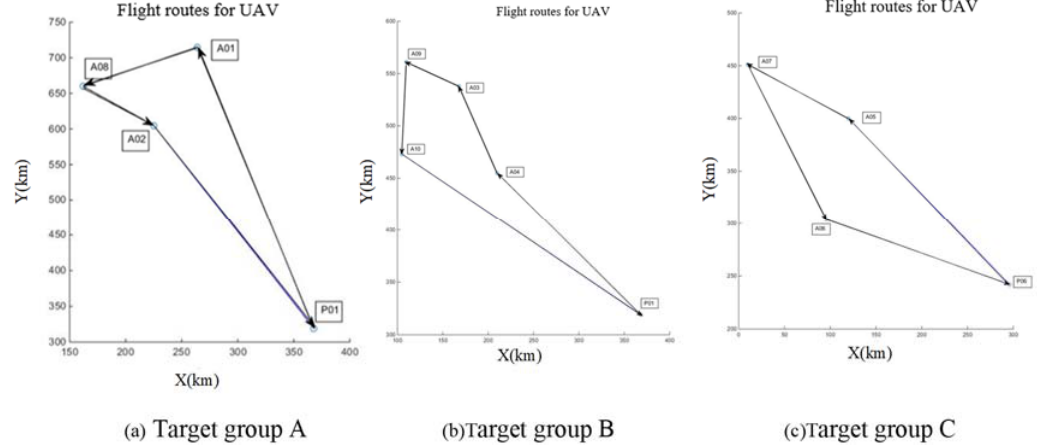
Figure 10. Results for the path planning and the average distance of multi ‐ UAVs in each target group: ( a ) target group A; ( b ) target group B; ( c ) target group